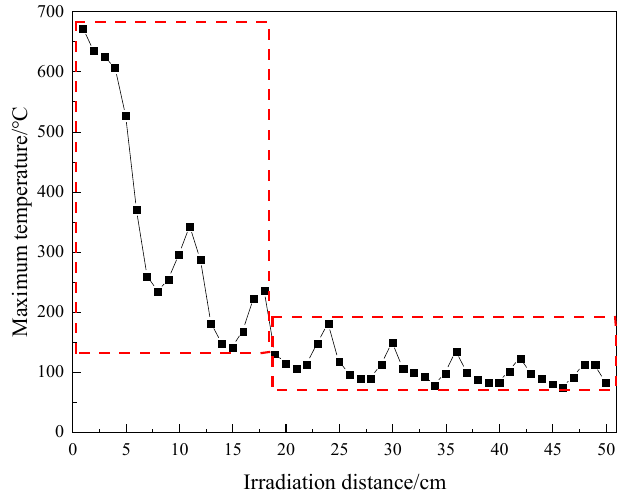
Figure 5. Relationship curve between the maximum temperature of the rock sample and irradiation distance.